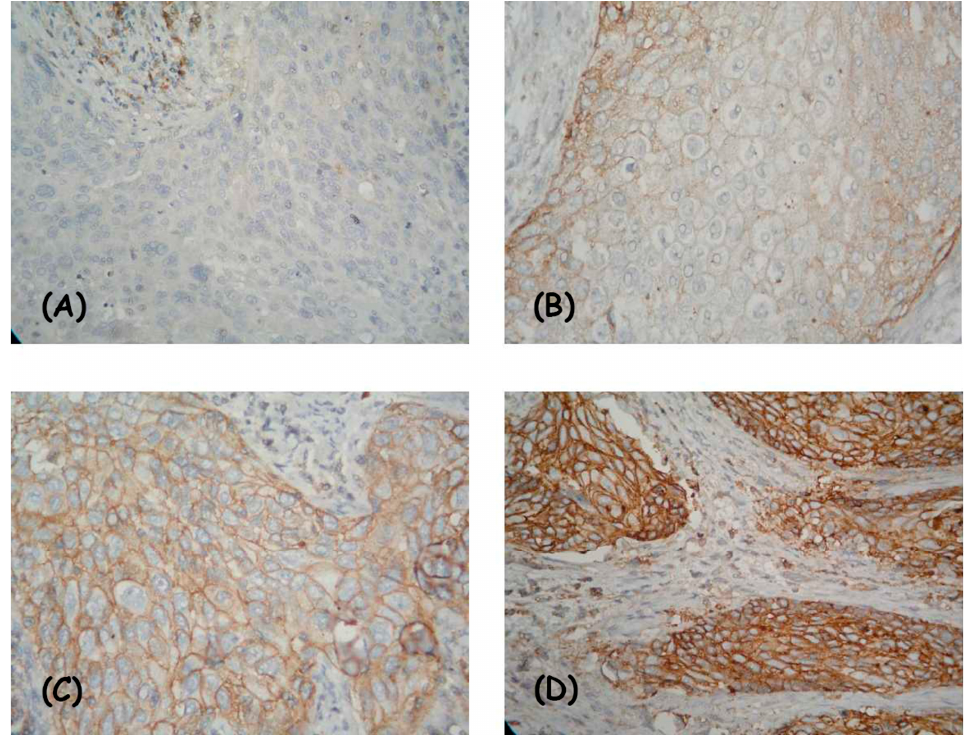
Figure 2. IHC expression model of CD47 in squamous cell cervical cancer: membrane positivity—missing ( A ), weak ( B ), average ( C ), and strong intensity ( D ). Magnification ×400.